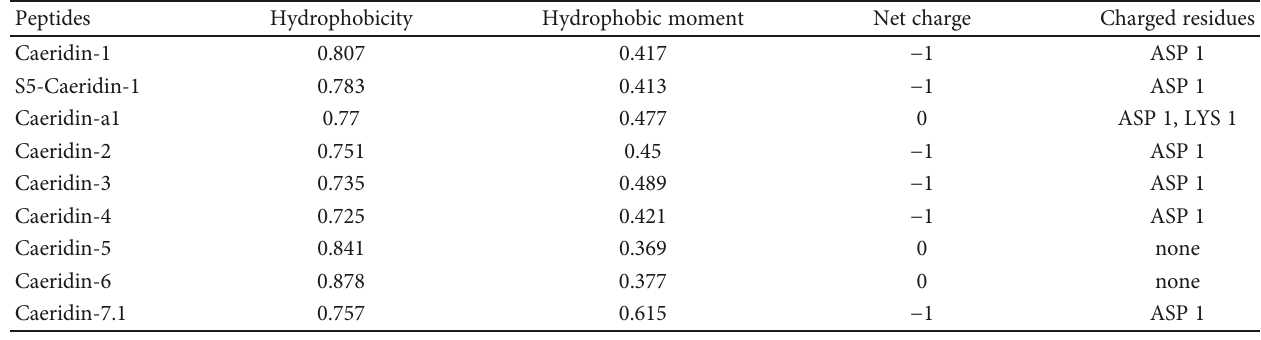
Table 3: Physicochemical properties of Caeridins determined by Heliquest.